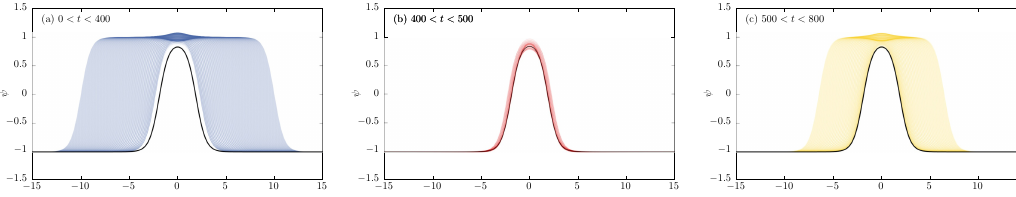
Figure 10 . Evolution of the field ψ obtained in the scattering of the initial configuration (5.1)–(5.2) with the purple mode ( n = 6) initially excited. Here A = 0 . 075 and solitons form a long living stationary solution ( t ∈ [400 , 550] ) localized at the BPS solution with b = 10 . 63 .